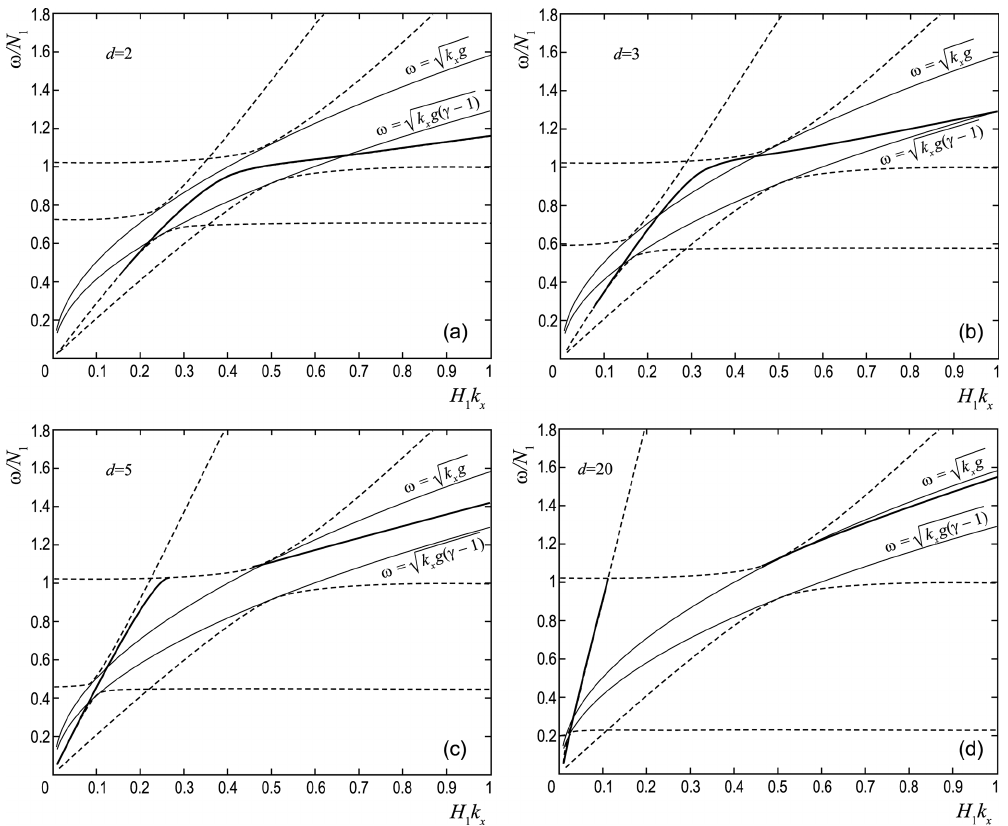
Figure 3. Dispersion dependencies of the ω = f (k x ) type at the temperature discontinuity boundary for d = 2 (a) , d = 3 (b) , d = 5 (c) , and d = 20 (d) . The dashed curves represent the boundaries of the areas with free propagation of AGWs in the upper and lower half-spaces,